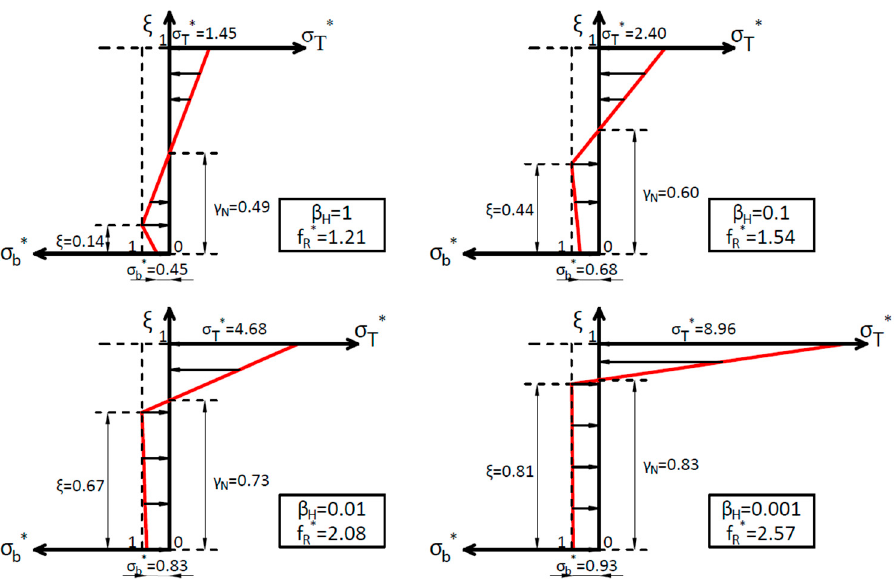
Figure 9. Non-dimensional stress profiles for β H,FRC = 1; 0.1; 0.01 and 0.001.